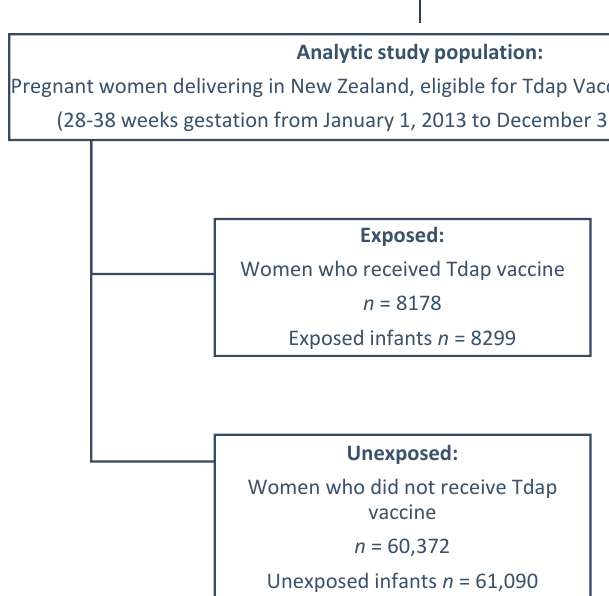
Figure 1. Flow of study population.